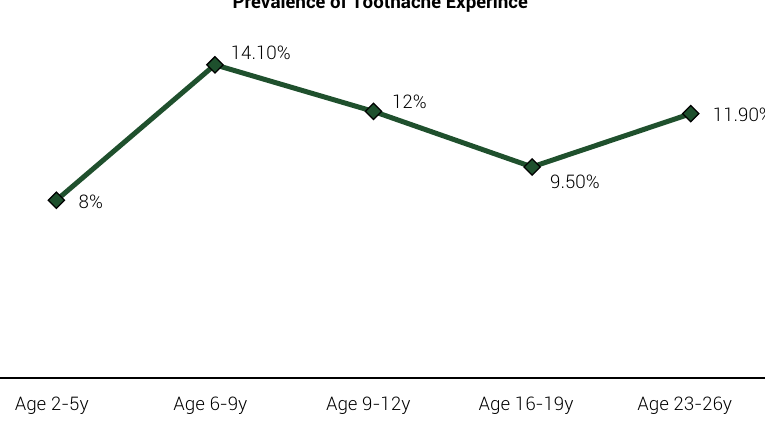
Figure 2. Toothache experiences in every period of life of the cohort